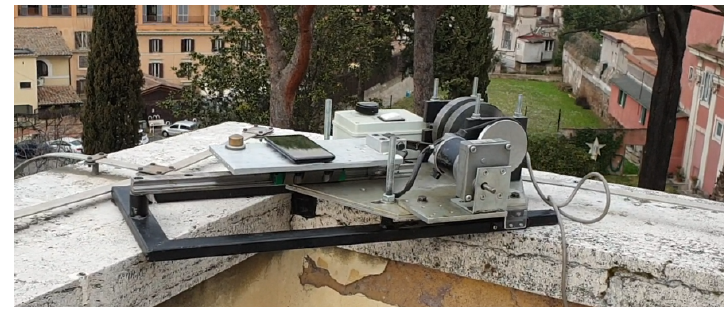
Figure 3. Vibrating table used to perform the